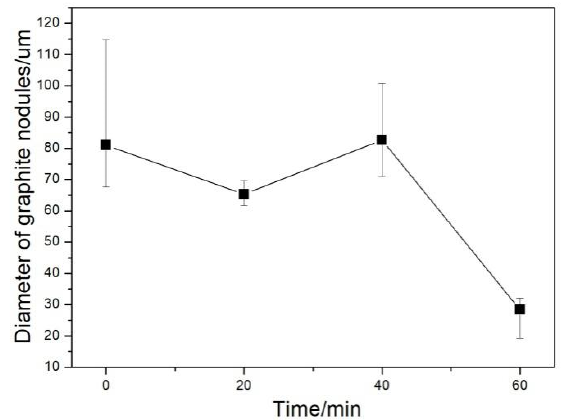
Figure 3. Diameter of graphite nodules in DI after injecting nitrogen gas for different time periods.